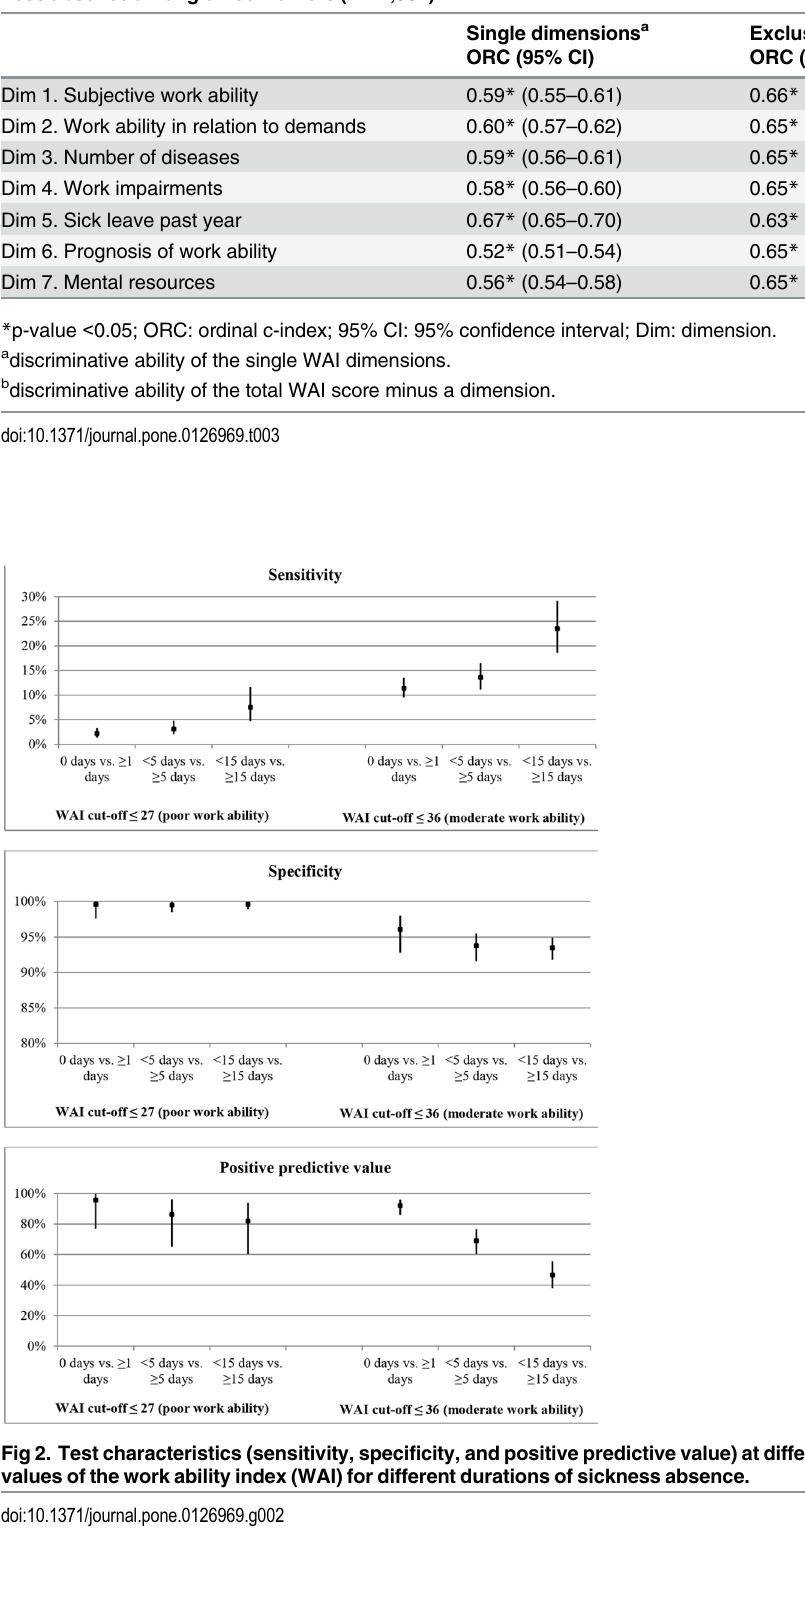
Table 3. Discriminative ability of the WAI dimensions in the prediction of different durations of sick- ness absence among office workers (n = 1,331).